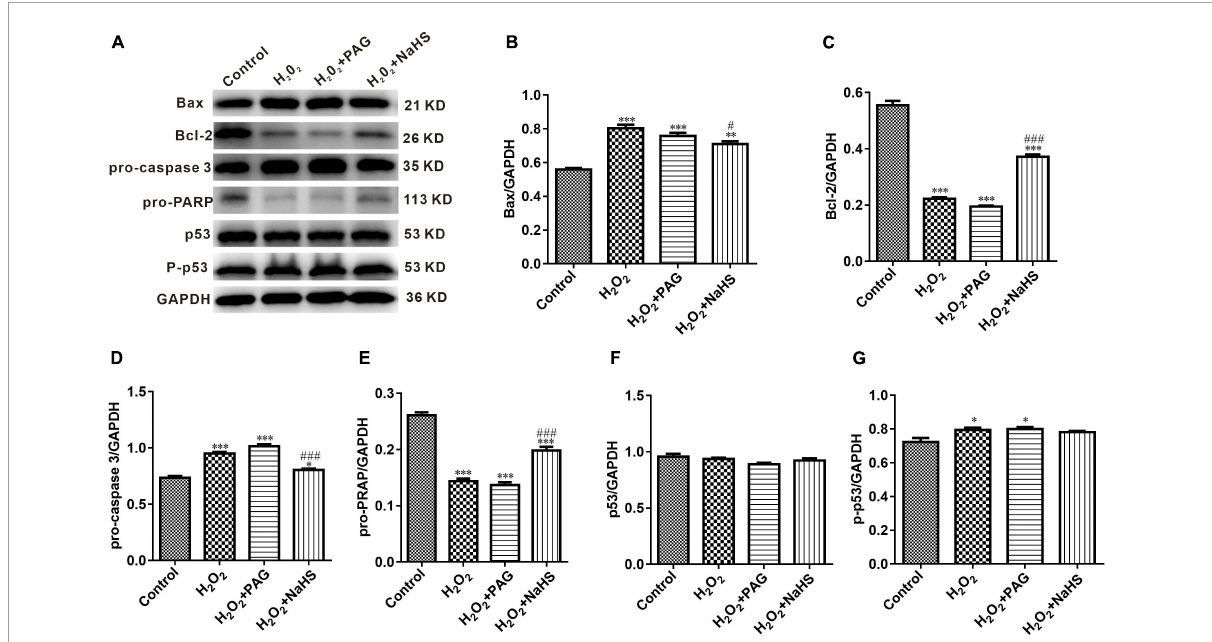
FIGURE6 Effect of NaHS on cell apoptosis pathway proteins activity in HTR-8/SVneo cells. (A) Representative western blot showing Bax, Bcl-2, pro-caspase 3, pro-PRAP, p53, and p-p53 in HTR-8/SVneo cells after different treatments. (B–G) Bar charts indicating different apoptosis-related proteins between different groups. Results were normalized against GAPDH. The data are expressed as mean ± SEM. ∗ Vs. Control, P < 0.05. ∗∗∗ Vs. Control, P < 0.001. # Vs. H 2 O 2 , P < 0.05. ### Vs. H 2 O 2 , P <